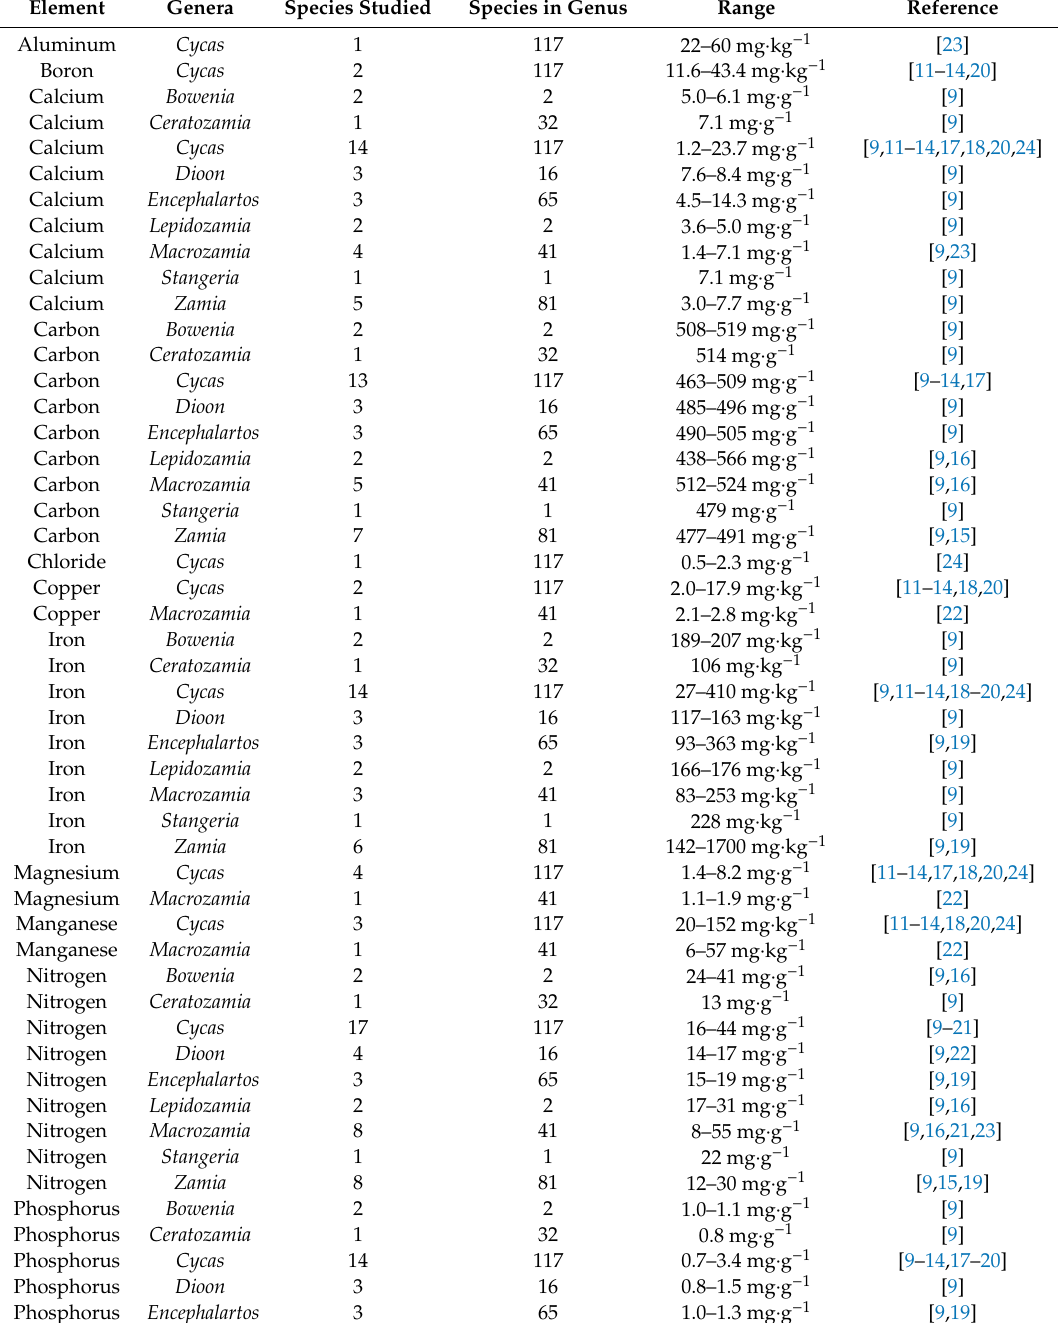
Table 2. Published ranges in green leaf concentrations of macronutrients, micronutrients, and beneficial elements for cycad